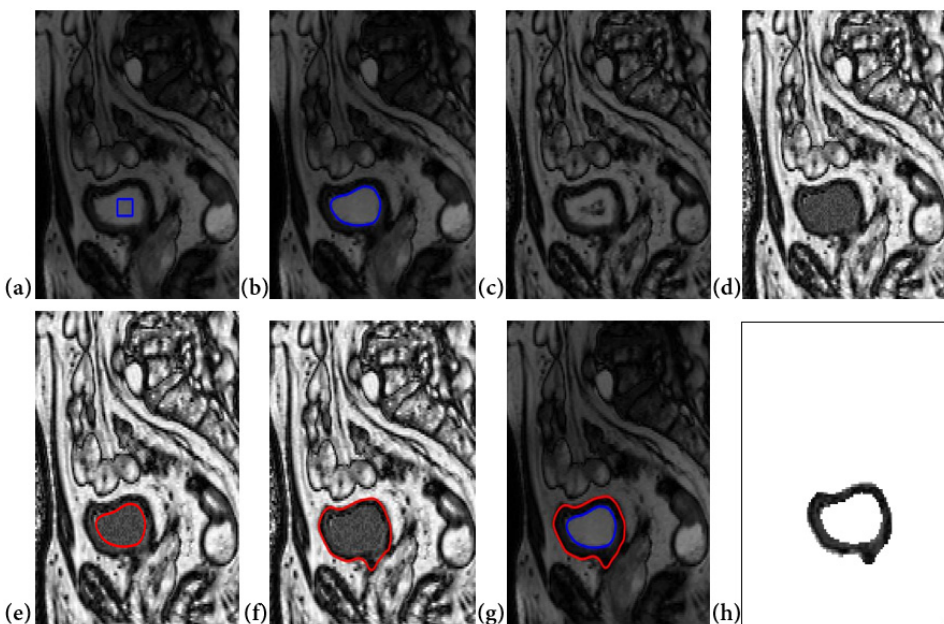
Figure 6. Segmentation procedure using our proposed algorithms: ( a ) Contour initialization inside the bladder , ( b ) the inner boundary segmented by the level set algorithm, ( c ) contrast enhanced generated image, ( d ) pixel intensity change inside the bladder according to the average intensity in the bladder wall, ( e ) inner segmentation result as initialization for the outer boundary research, ( f ) the outer boundary segmented, ( g ) inner and outer contours and ( h ) bladder wall extracted.